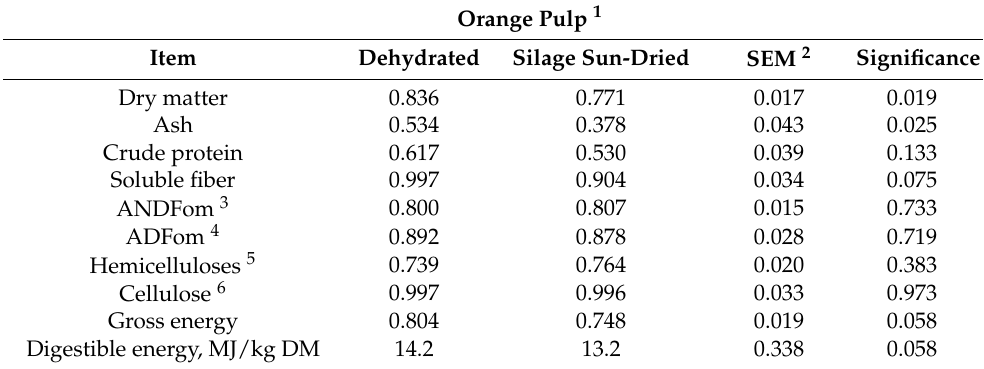
Table 5. Coefficients of apparent total tract digestibility and digestible energy of dried orange